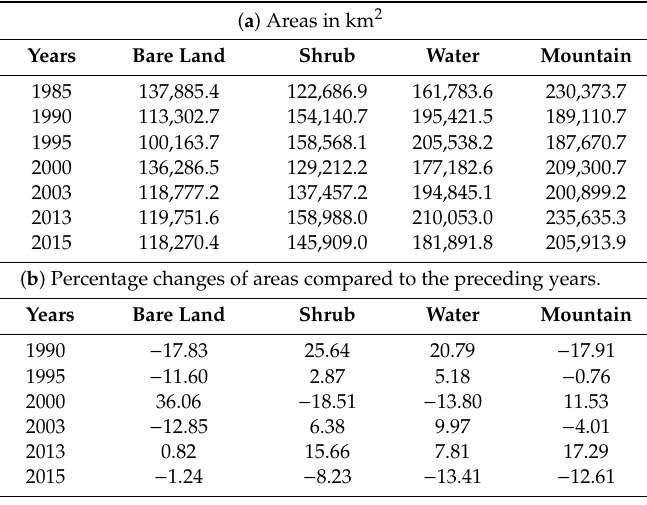
Table 4. Areas of bare land, shrub, water and mountain in the study